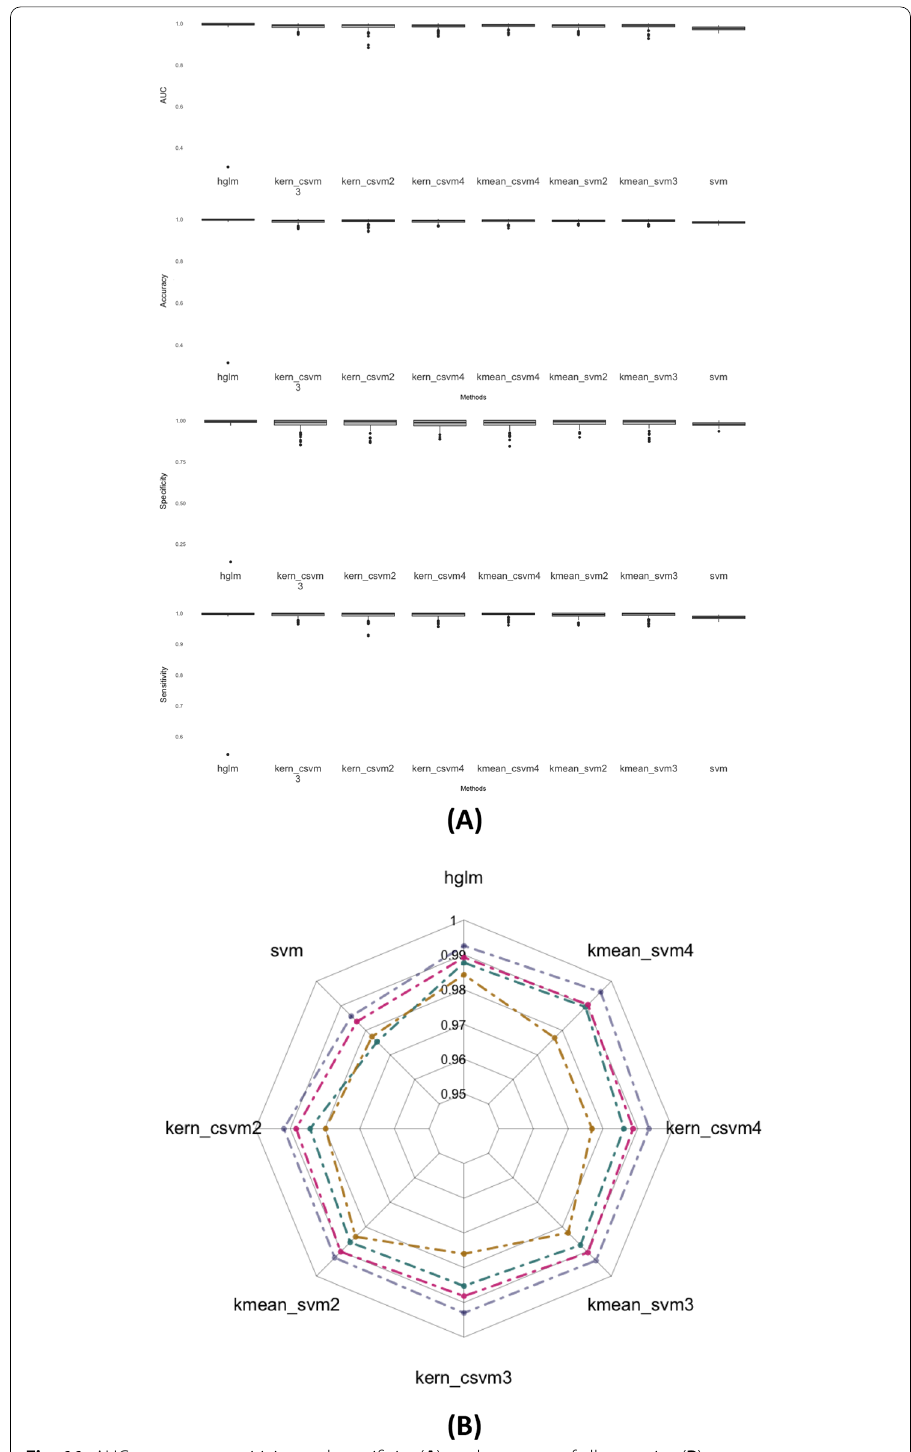
Fig. 11 AUC, accuracy, sensitivity, and specificity ( A ), and accuracy of all scenarios ( B